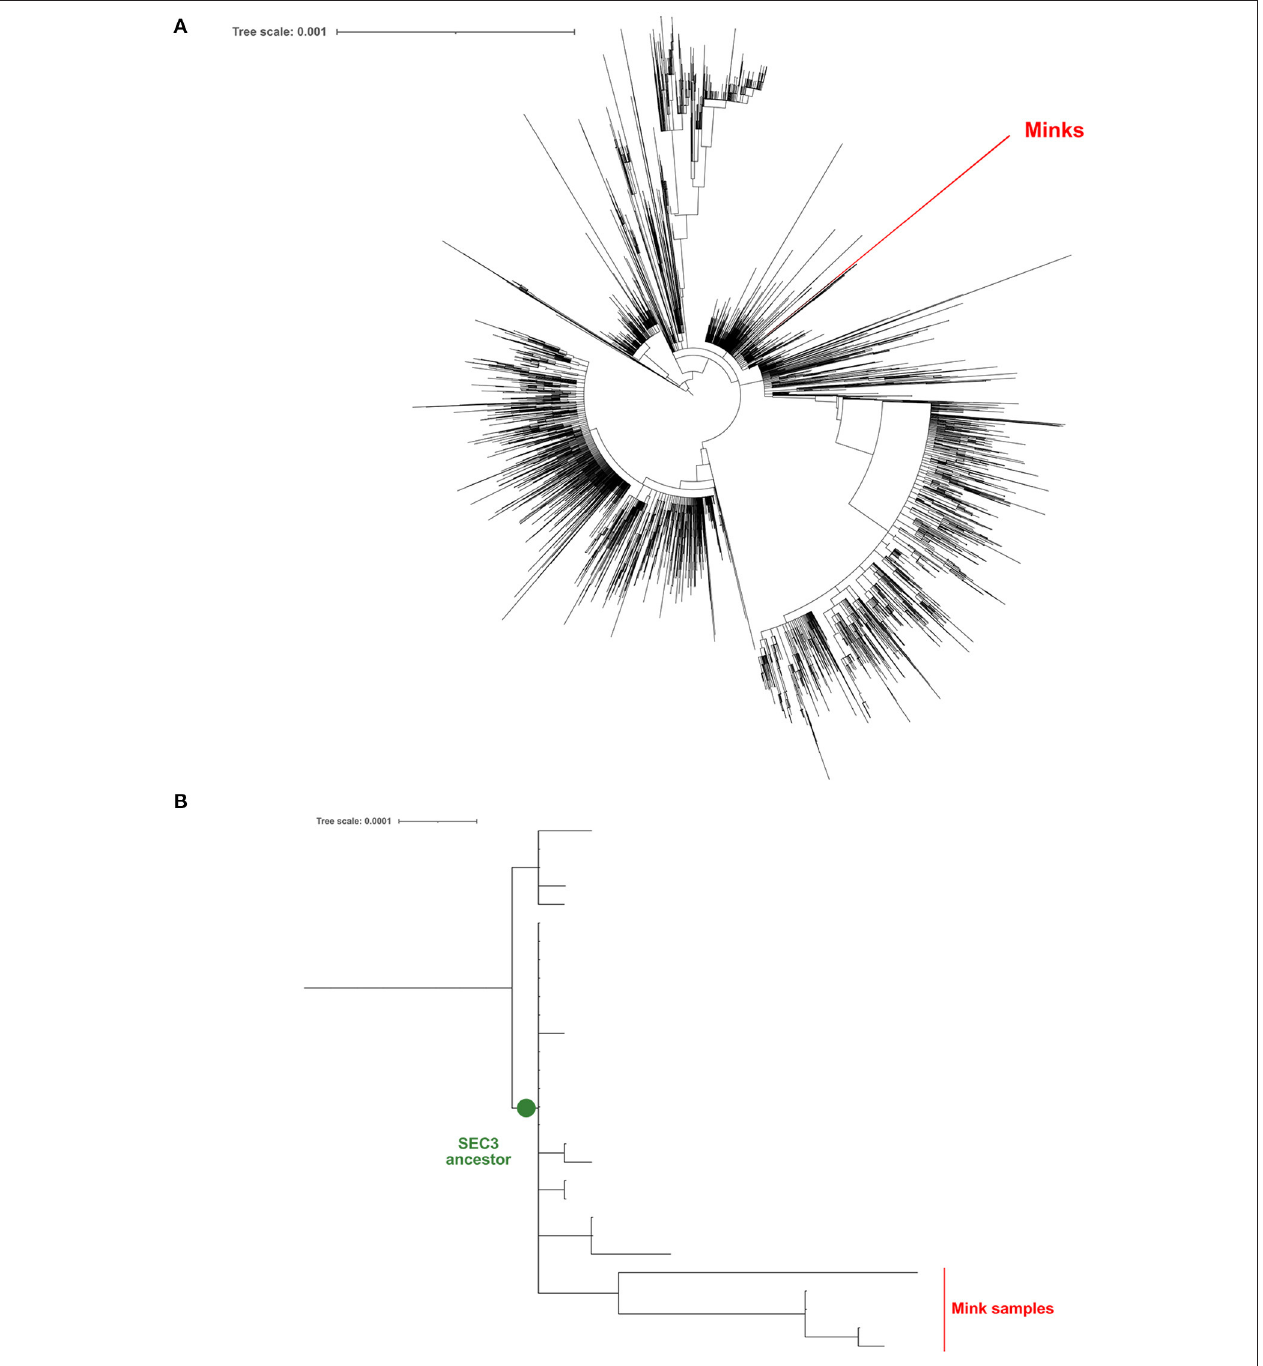
FIGURE 1 | Maximum-likelihood phylogeny constructed using the genomic sequences obtained from mink samples and all the complete sequences processed by the SeqCOVID consortium at 15/09/2021. (A) Phylogeny tree; (B) A zoomed view of the phylogeny, focusing on the SEC3 clade.